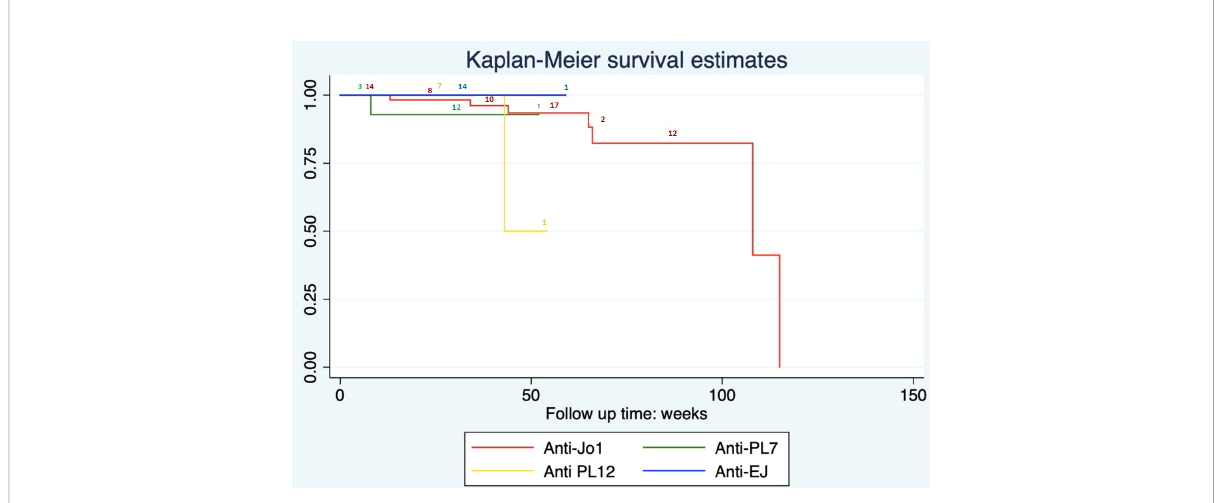
FIGURE 2 Survival duration of ASS-ILD patients with different ASA antibody